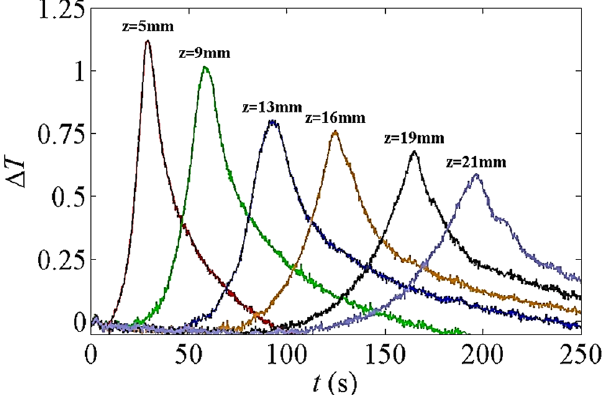
Figure 19. Temperature rise at various imbibition heights over time.